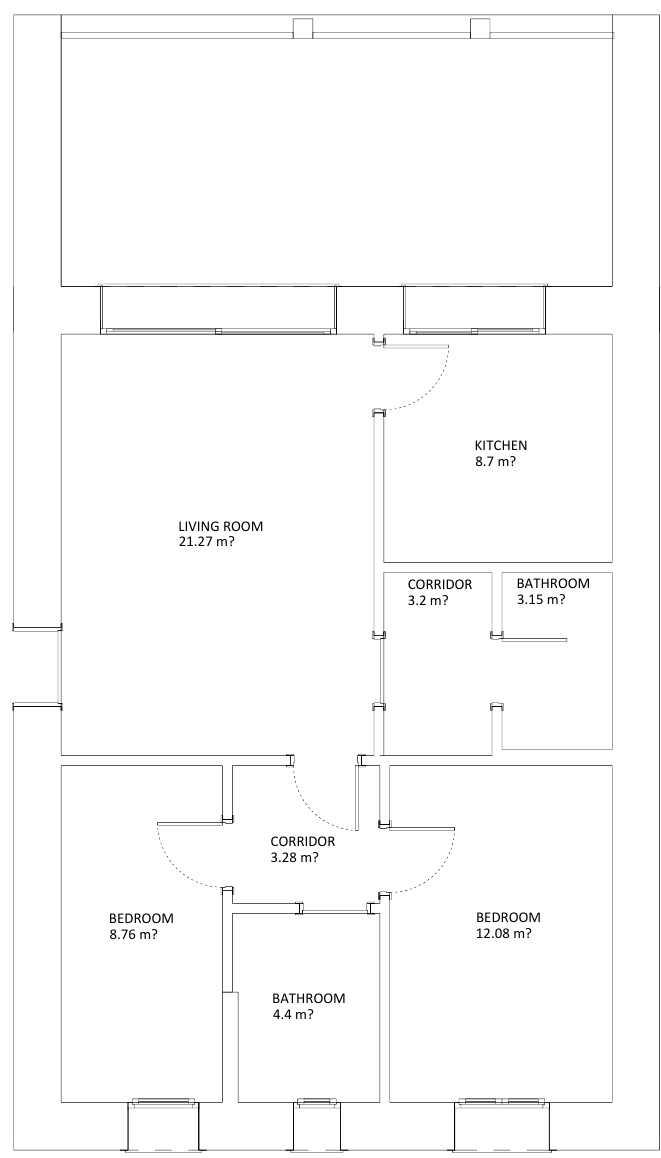
Figure 4. Three-room apartment plan.